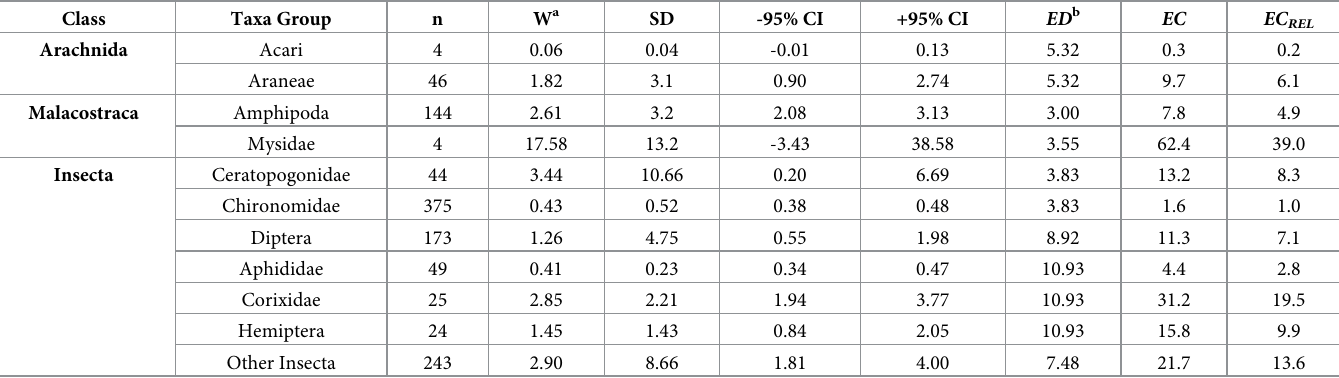
Table 2. Prey taxa mean weights ( W ; mg wet weight) and statistics, and values of energy density ( ED , J/mg) and energy content ( EC ; J/ind). Class